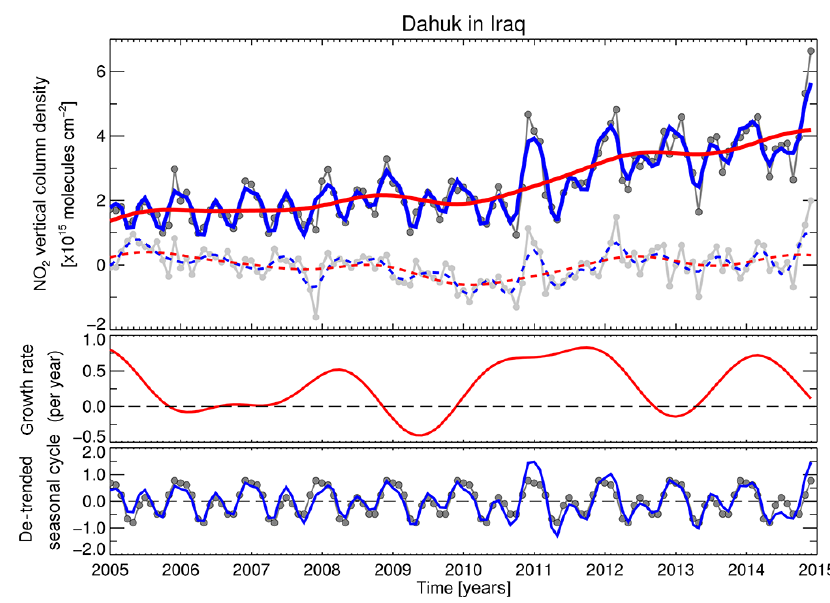
Figure 3. An example of a time series fit to observed NO 2 data over Dahuk, Iraq, as outlined in Sect. 3.3. (Top) The monthly OMI NO 2 vertical columns are indicated by dark grey filled circles, whilst the light grey filled circles represent the fitting residual, which has been smoothed with a short-term 200-day filter (dashed blue line) and long-term 667-day filter (red dashed line). The solid red line is the long- term trend F T (t) , given by the linear component of the fitted function F(t) (Eq. 1) plus the residual filtered using the long-term filter. The solid blue line is the smoothed fitted curve F S (t) given by F(t) plus the residual filtered using the short-term filter. (Middle) The NO 2 vertical column growth rate in × 10 15 moleculescm − 2 yr − 1 , which is the derivative of the long-term trend F T (t) shown in the top- panel. (Bottom) The de-trended seasonal cycle F C (t) , which is the difference between the long-term trend and the smoothed function fit (i.e. F S (t) − F L (t) ). This represents the annual seasonal oscillation with any long-term trend removed. The dark grey filled circles are the fitted harmonic components of F(t)